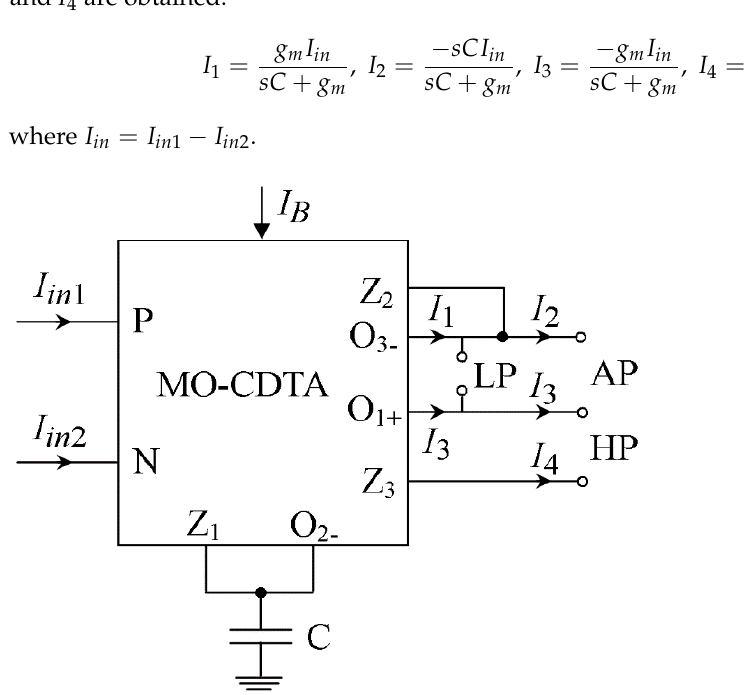
Figure 2. The proposed fully differential configuration realizing first-order filters.